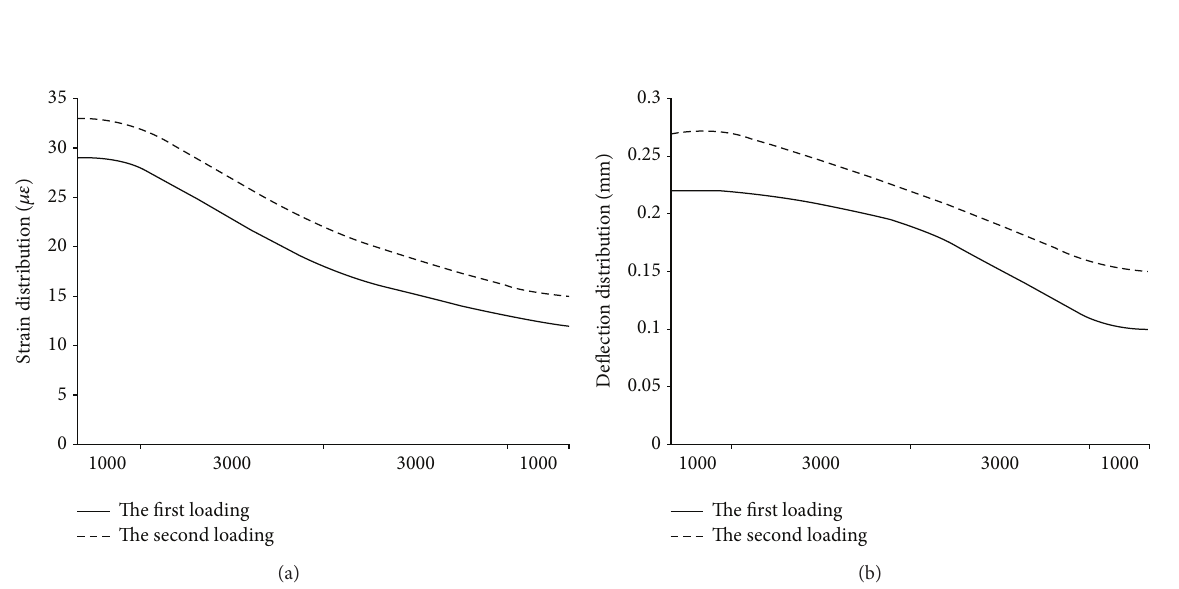
Figure 12: Deflection and strain distribution on the test cross section under the second condition: (a) strain distribution/ 𝜇𝜀 and (b) deflection